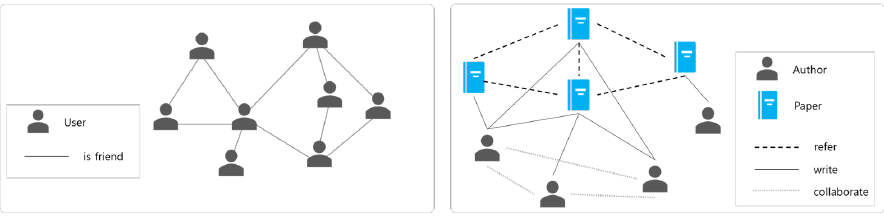
Figure 1. ( a ) Homogeneous Information Network ( b ) Heterogeneous Information